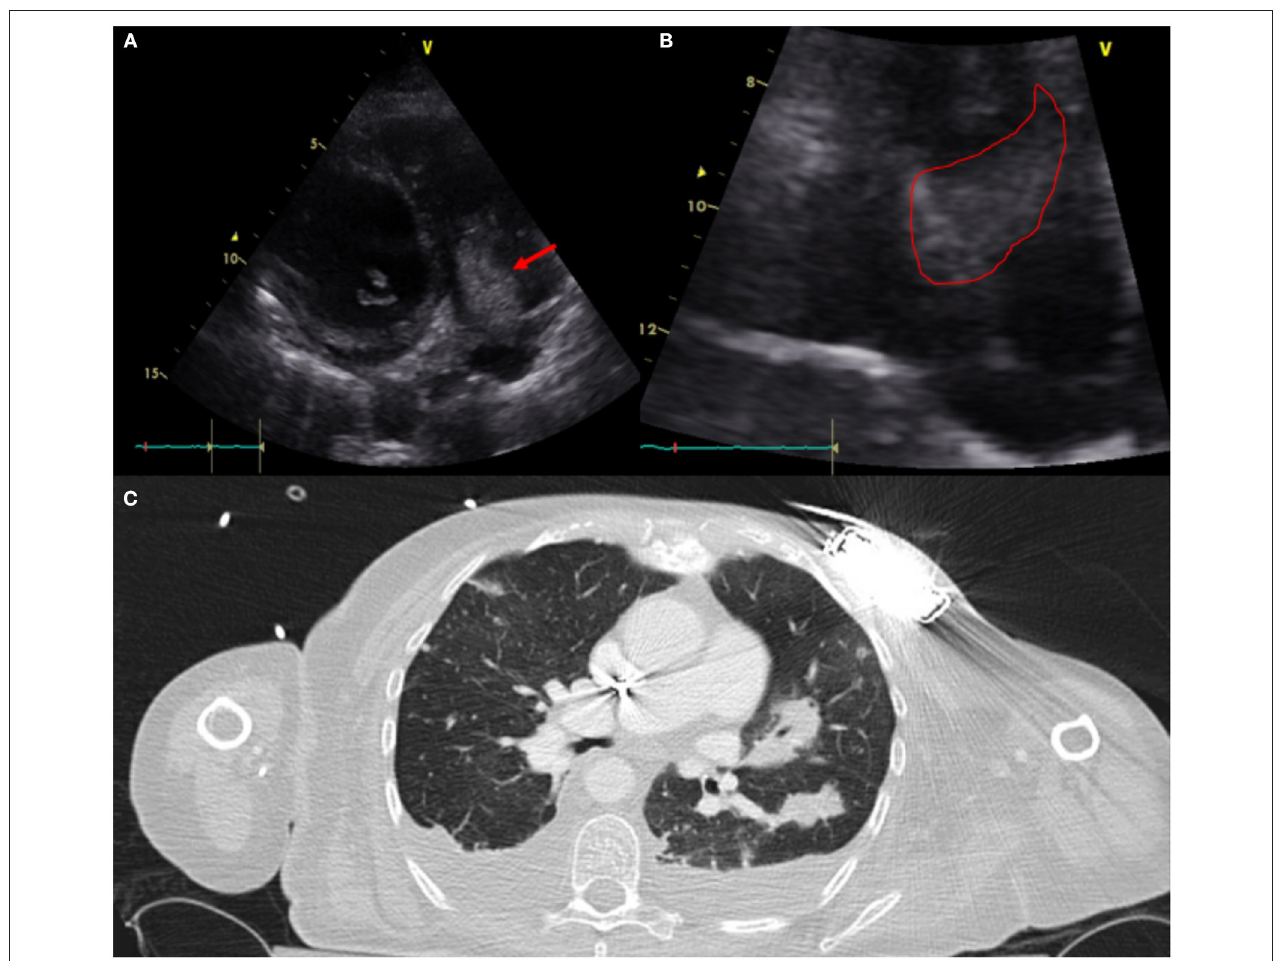
FIGURE 3 | Sixty one year-old woman with a history of NICM s/p single lead ICD who presented with fever and malaise. Infectious work up was positive for MSSA bacteremia. TTE showed a very large vegetation attached to the ICD lead in the RA protruding into the RV [ (A) -modified apical view and (B) -RV focused view with RA zoom]. A pre-procedural CT (C) was obtained and revealed bilateral, extensive and multifocal septic emboli with cavitary lesions as well as bilateral pleural effusions without evidence of pocket infection. The patient underwent open sternotomy with device extraction and TV repair for septal leaflet perforation for management of CIED systemic infection with